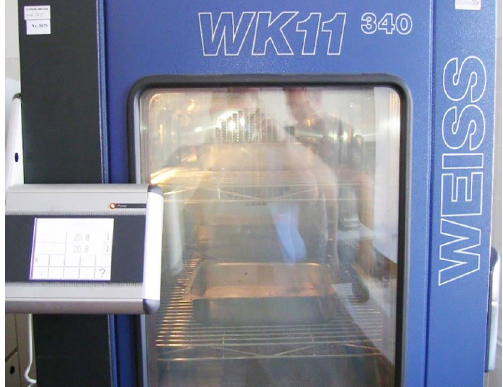
Fig. 4. Climatic chamber, where the sample was kept at different